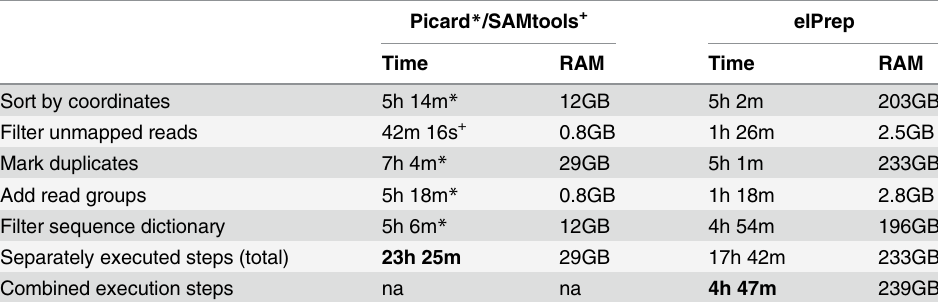
Table 6. Benchmarks of the 5-step pipeline on NA12878 whole genome (JP protocol). Picard * /SAMtools + elPrep Time RAM Time RAM 5h 14m * 12GB 5h 2m 203GB